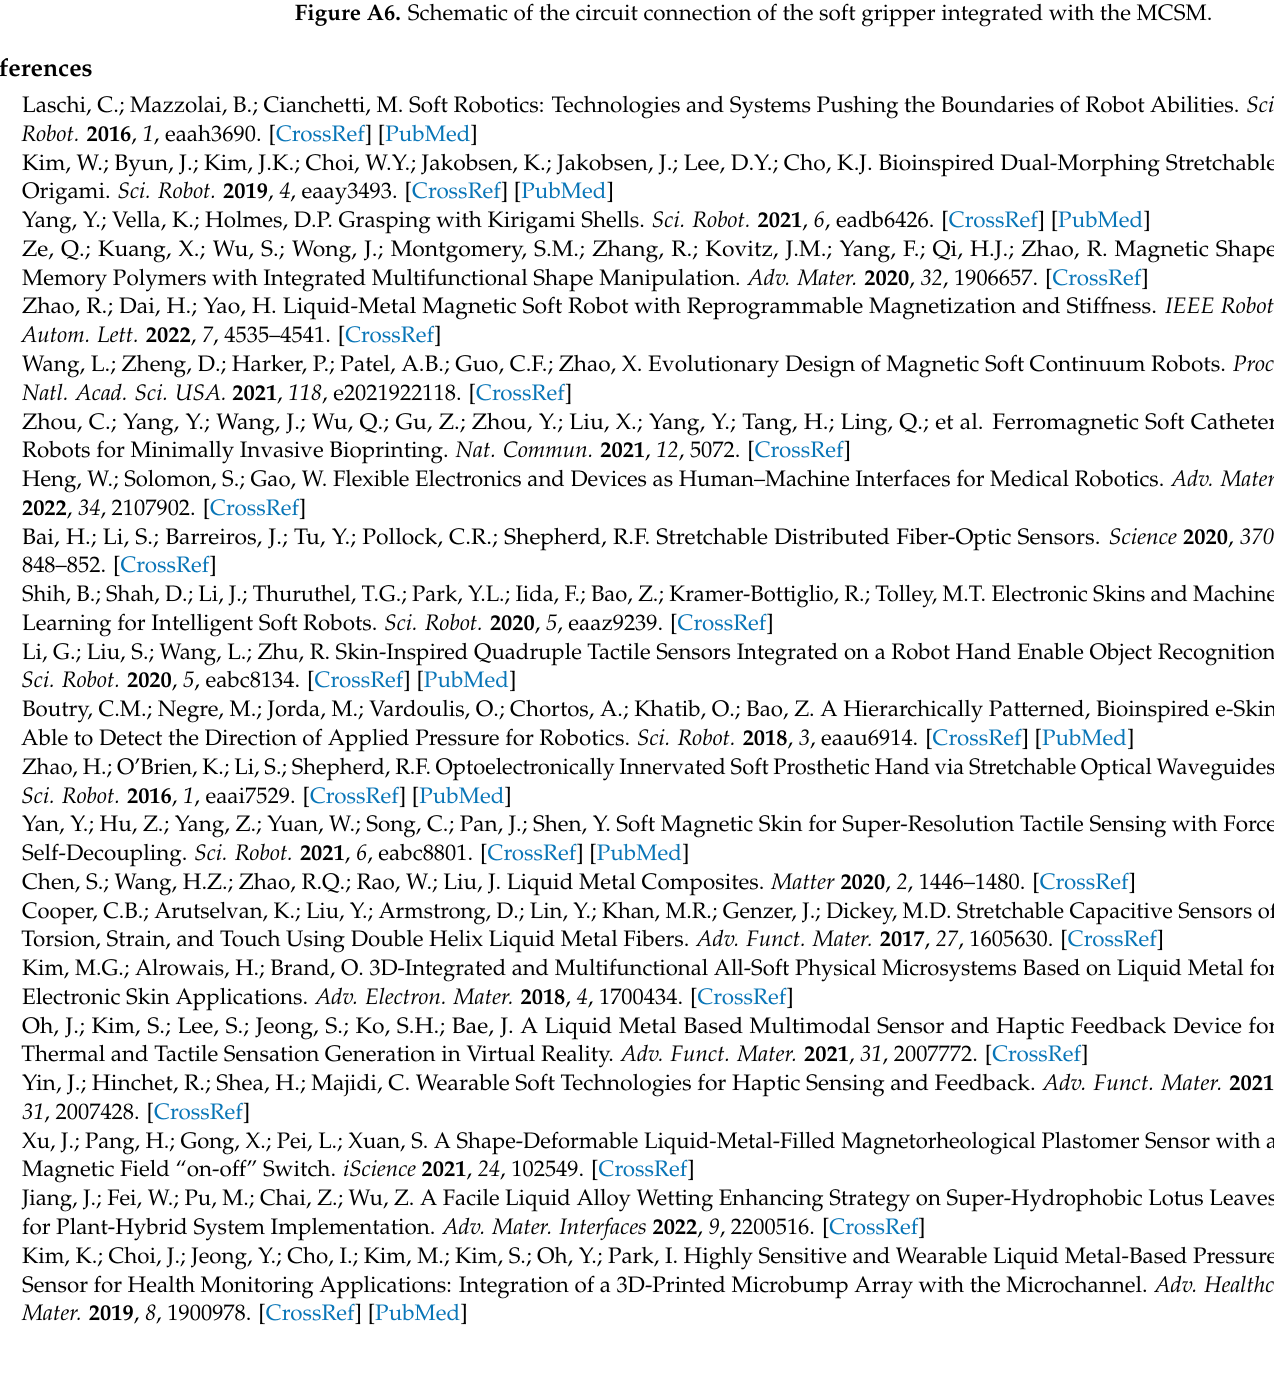
Figure A6. Schematic of the circuit connection of the soft gripper integrated with the MCSM.